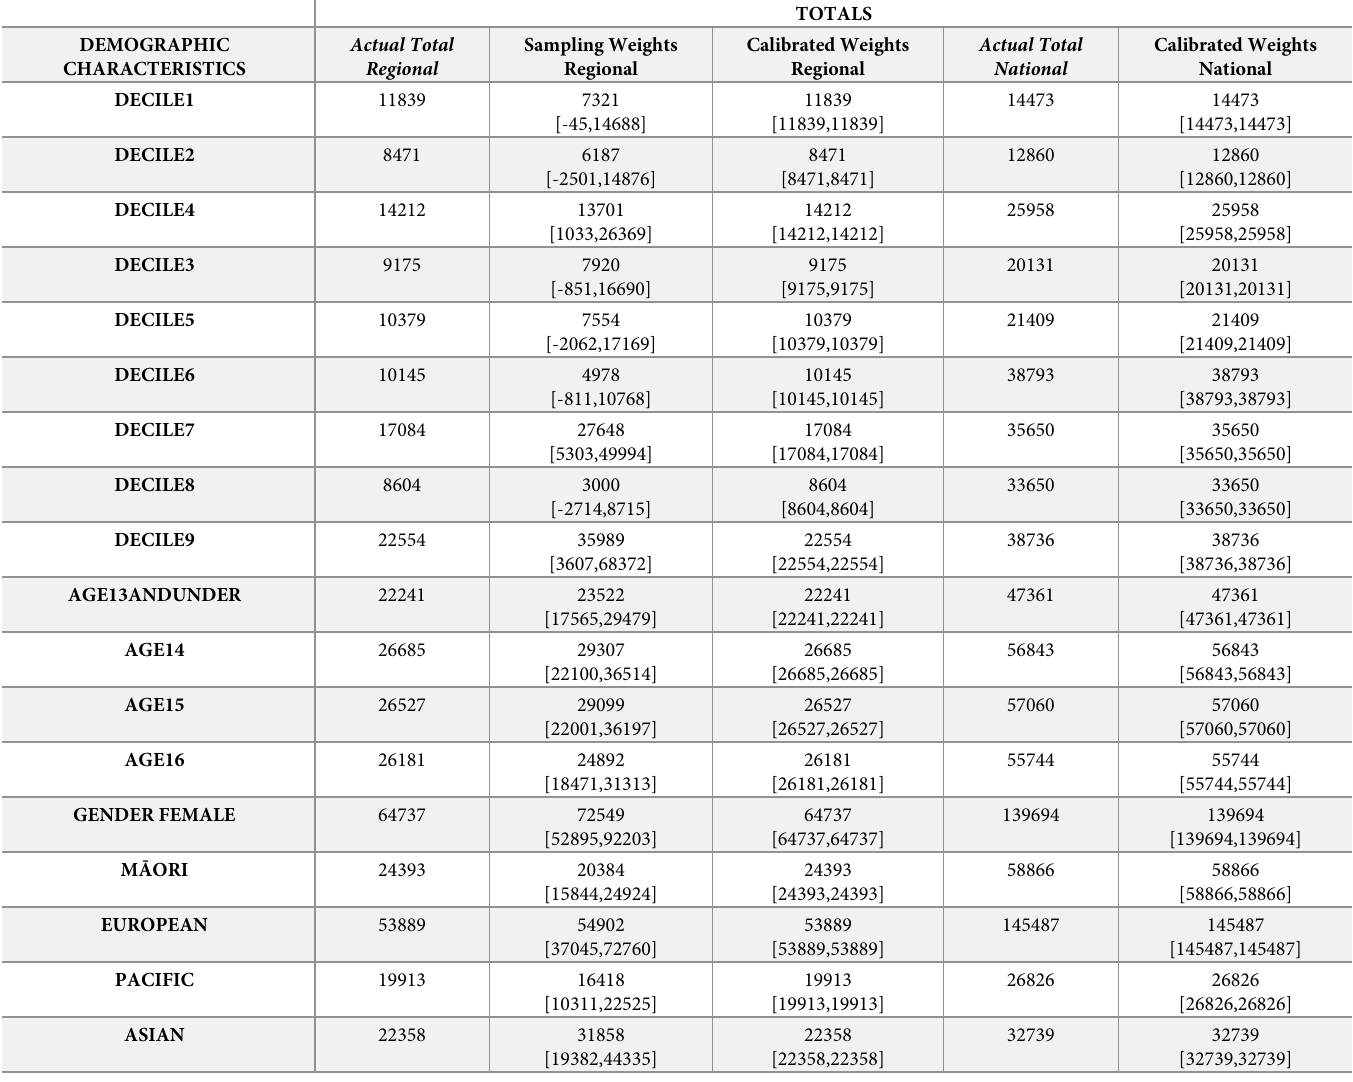
Table 3. National and regional student population estimates- comparison of actual quantities, estimates using sampling weights and estimates using calibrated weights.